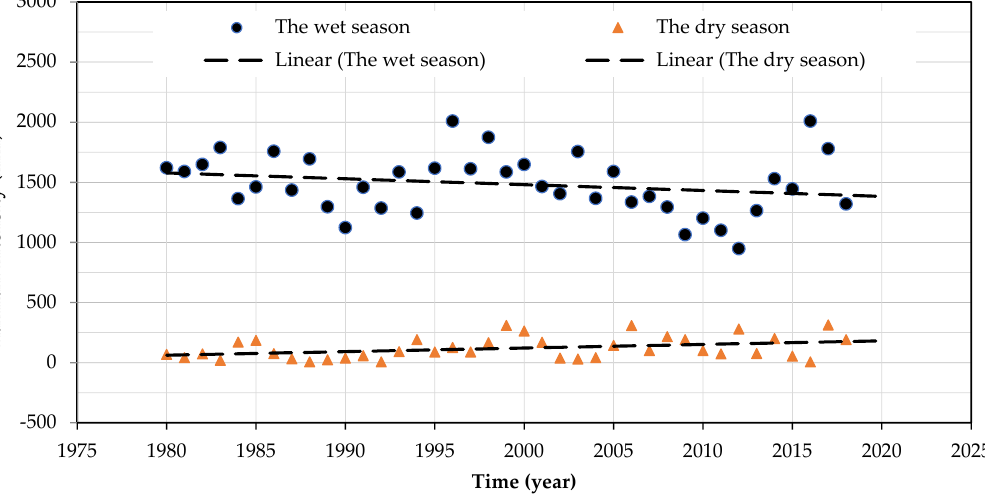
Figure 4. Total rainfall in the wet season (from May to December) and in the dry season (from December to April) at Can Tho station.